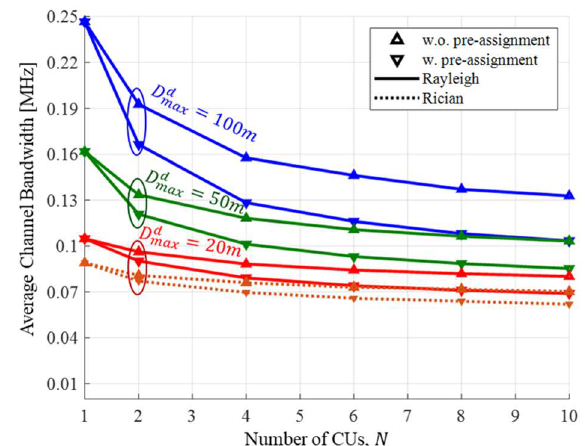
Figure 6. Average channel bandwidth versus the number of CUs with and without channel pre- assignment .